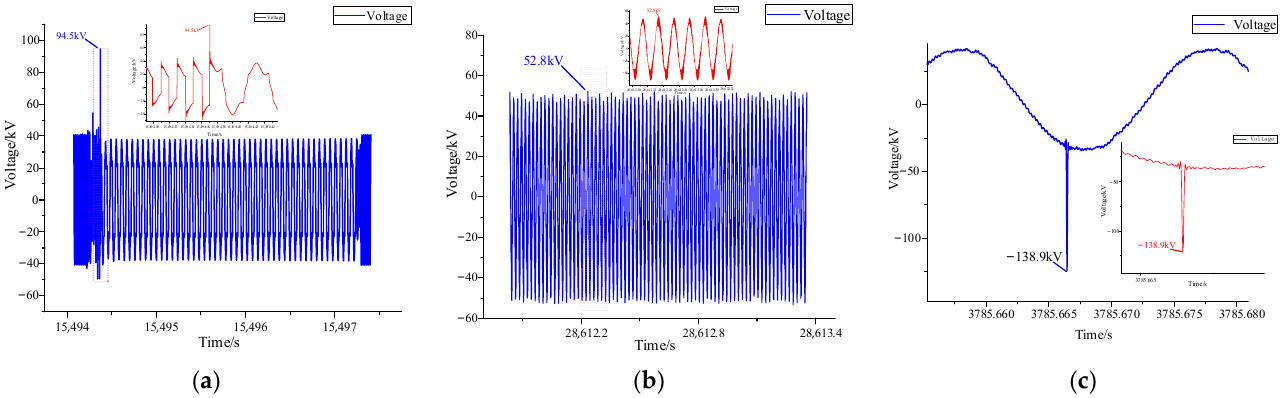
Figure 8. Three typical overvoltage waveforms. ( a ) Passing section overvoltage. ( b ) High-harmonic overvoltage. ( c ) Steep impulse overvoltage.